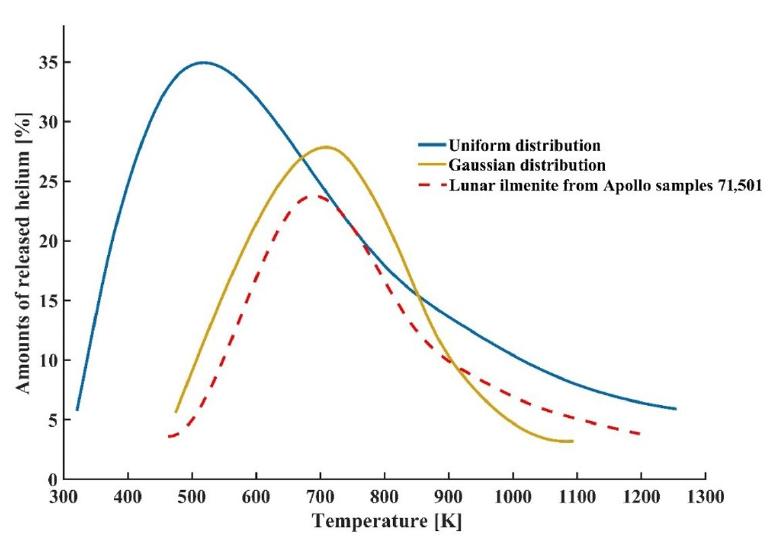
Figure 4. Release patterns of helium between molecular dynamics simulations with different concentration profiles and the thermal release experiment in ilmenite from Apollo samples 71,501 [29].